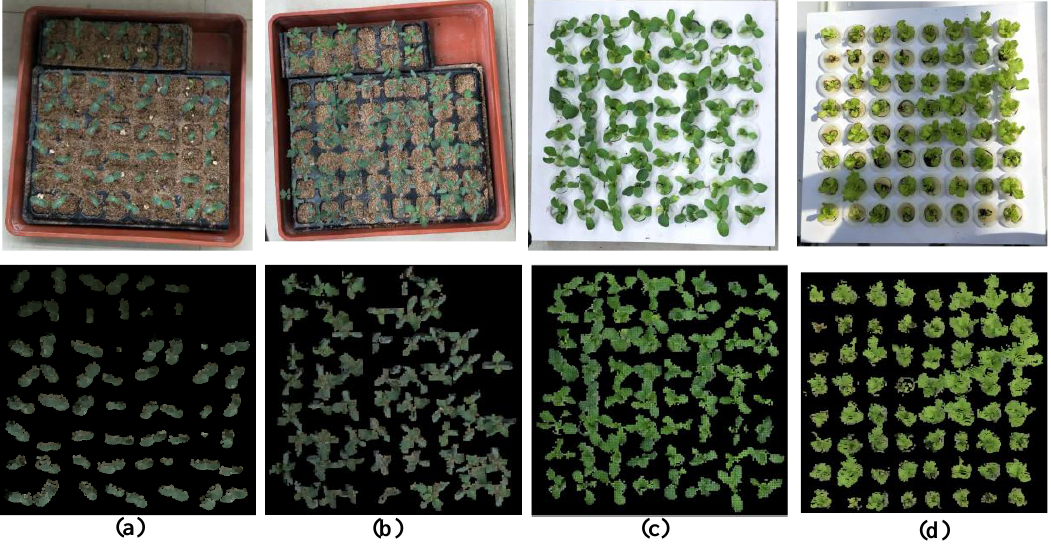
Figure 7. Typical example of the removal of natural background processing results from four varieties of vegetable seedlings planted in different seedling trays and growing in two types of environment: ( a ) cucumber ( b ) tomato, ( c ) pak choi cabbage, ( d ) lettuce; ( a , b ) soil culture, ( c , d ) hydroponic; ( a – c ) grown in plant factory, ( d ) grown in greenhouse. Parameters: r N = 3.5 mm, r H = 11.5 mm.